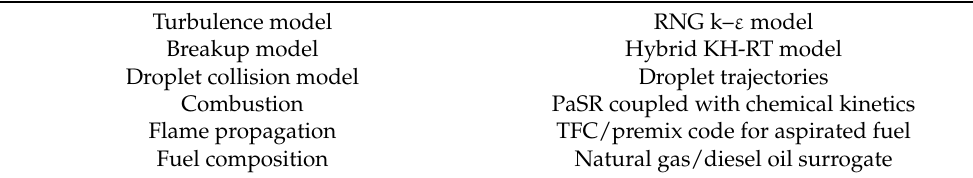
Table 2. Main models used for the 3D-CFD engine modeling. Turbulence